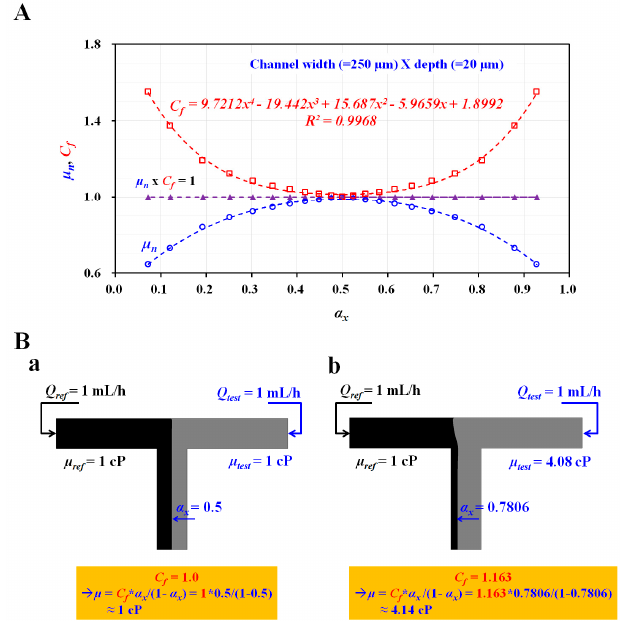
Figure A2. A correction factor of the parallel flow method estimated by conducting a numerical simulation. ( A ) The polynomial formula of a correction factor ( C f ) estimated from a numerical simulation. ( B ) Numerical simulation results for showing interfacial location depending on the viscosity of test fluid. ( a ) α x = 0.5 for μ test = 1 cP. Viscosity of test fluid was estimated as 1 cP by considering correction factor of C f = 1. ( b ) α x = 0.7806 for μ test = 4.08 cP. The viscosity of test fluid was estimated as 4.14 cP by considering the correction factor of C f = 1.163.